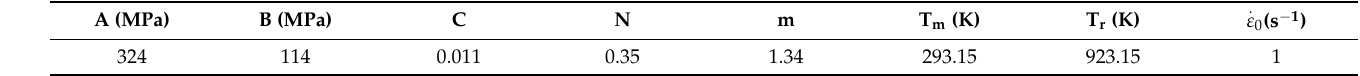
Table 2. Johnson-Cook model parameters of Al6061-T6 [30].